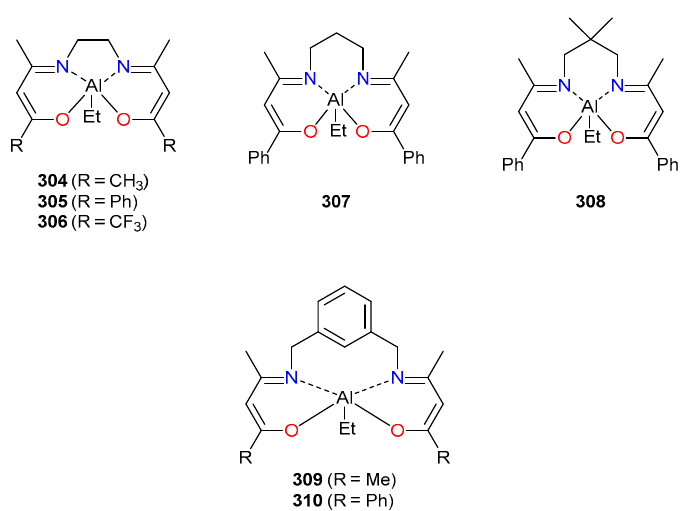
Figure 45. Enolic Schiff-base aluminum complexes 304–310 [129].